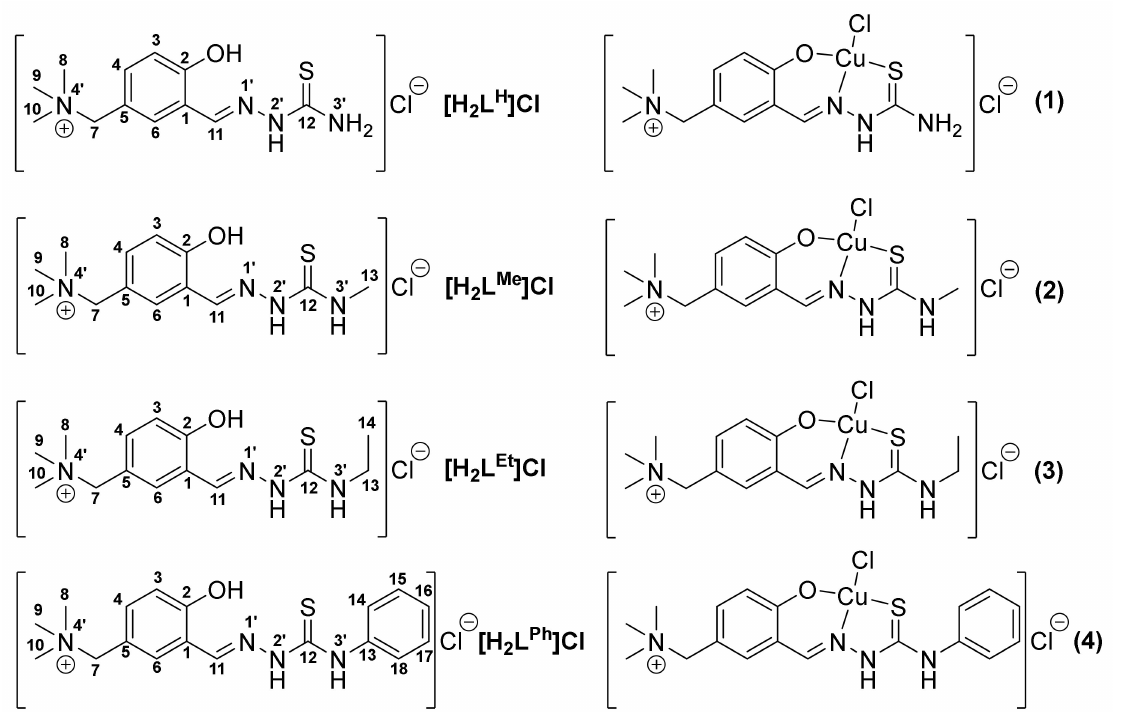
Figure 2. The line drawings of salicylaldehyde thiosemicarbazone (STSC) analogues [H 2 L R ]Cl and their copper(II) complexes 1 – 4 . The C atoms (1–18) and N atoms (1 (cid:48) –4 (cid:48) ) labelling in the proligands is used for NMR resonances